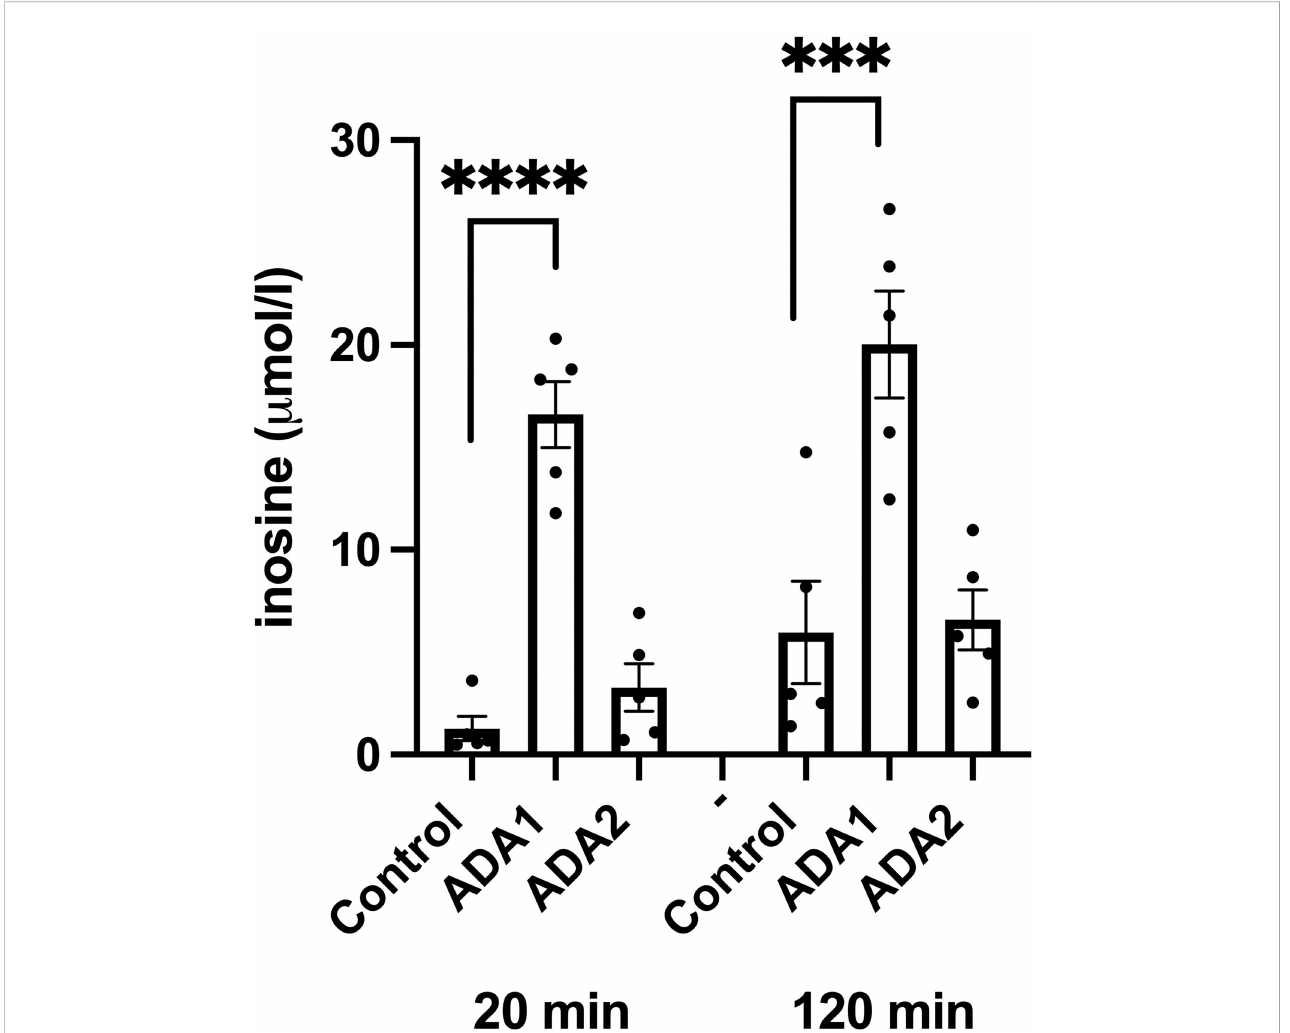
FIGURE 6 ADA1 overexpression, but not ADA2 overexpression, leads to increased inosine production. EndoC-betaH1 cells were transduced with ADA1 (2000 IFU/ cell) or ADA2 (25 VP/cell) and analyzed for inosine production the next day in the presence of 50 m M adenosine. Results are inosine concentrations in the extracellular KRBH